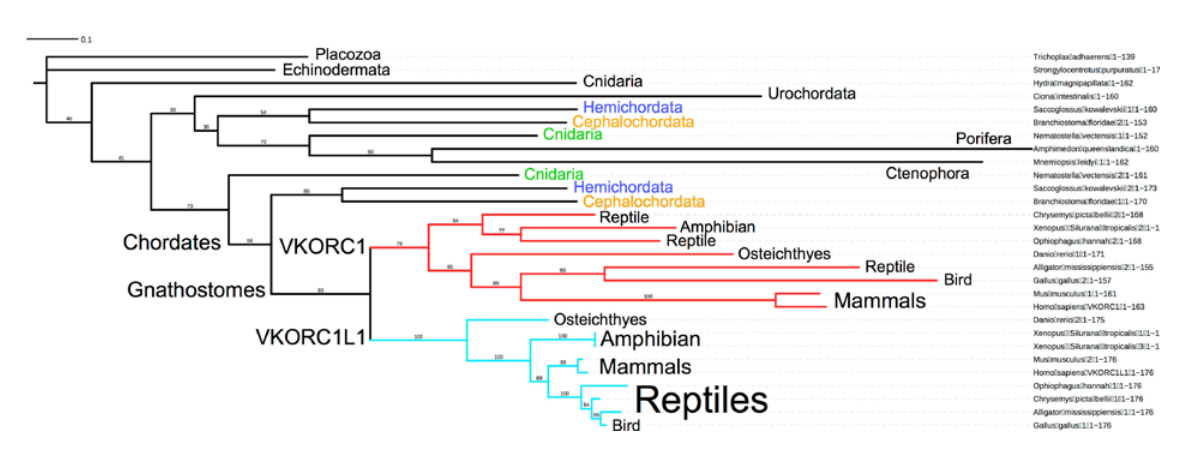
Figure 2. Reconstructed phylogeny (unrooted) for full-length sequences of index metazoans using PhyML with a WAG+I+G4 substitution model in the IQ-TREE ver1.2.3 server-based